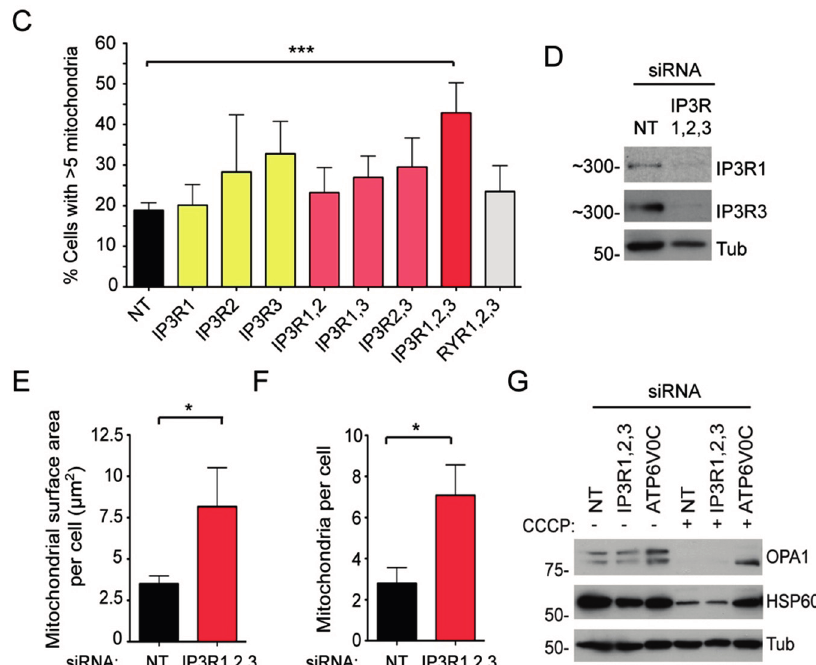
Figure 4. Analysis of potential redundancy in the original screen identifies the IP3Rs. ( A ) Combined siRNA targets and qualitative assessment of mitophagy; ( B ) Example images of mitophagy in YFP-Parkin RPE1 cells suppressed for IP3R1,2,3 (NT = non-targeting control); scale bar = 10 µm. ( C ) Quantitation of mitophagy in YFP-Parkin RPE1 cells suppressed for the targets shown. Cells were treated with CCCP for 24 h. *** p < 0.001 one-way ANOVA, Tukey’s post -test; ( D ) Immunoblot showing levels of suppression for IP3R1 and IP3R3 in cells suppressed for all 3 IP3Rs; ( E , F ) Quantitation of mitophagy in CCCP (24 h) treated cells suppressed for IP3R1,2,3. * p < 0.05 t -test; ( G ) Immunoblot of mitochondrial proteins (OPA1; HSP60) in YFP-Parkin RPE1 cells suppressed for IP3R1,2,3. 2.3. Local Elevated Cytosolic Ca 2+ Is Needed for Efficient Parkin-Mediated